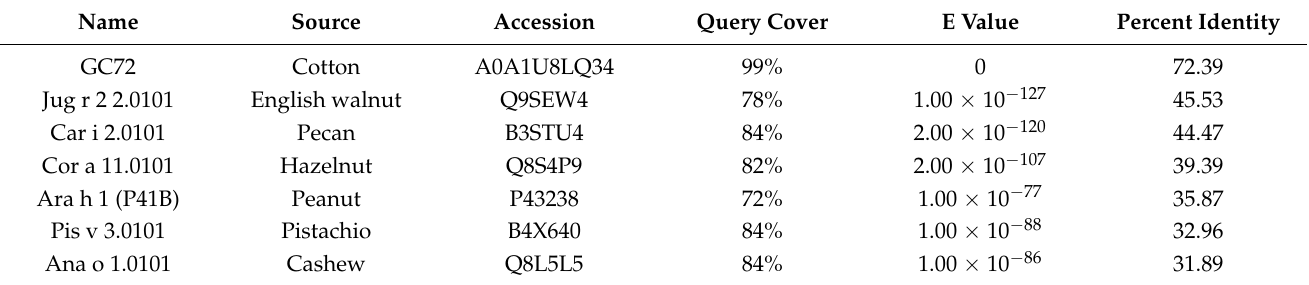
Table 3. C72 Vicilin Sequence